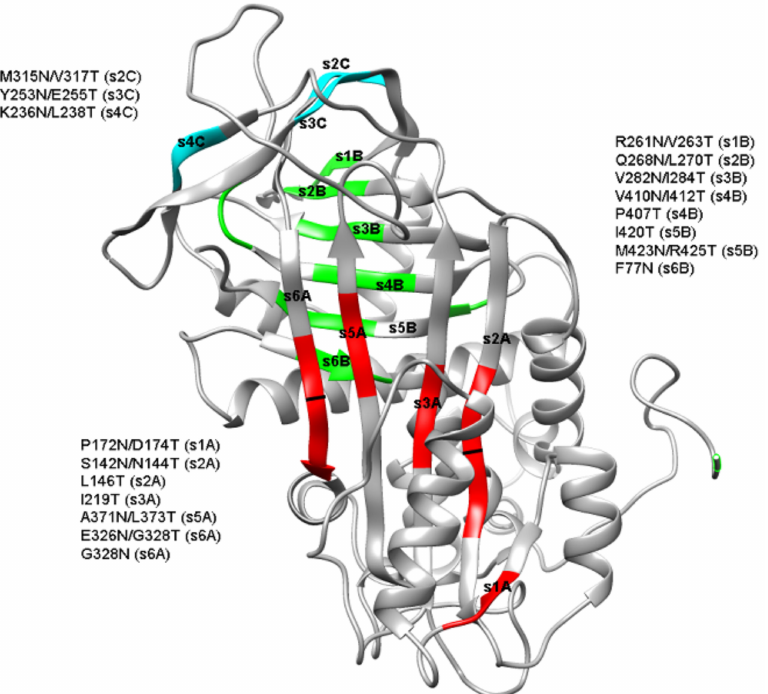
Figure 1. Structural representation of the mutations generated in the beta-strands of antithrombin. The consensus sequences generated at each strand are colored depending on the sheet to which they belong (red for the A-sheet, green for the B-sheet, and cyan for the C-sheet). Images were rendered with Pymol using Protein Data Bank (PDB): 1t1fA as a template.